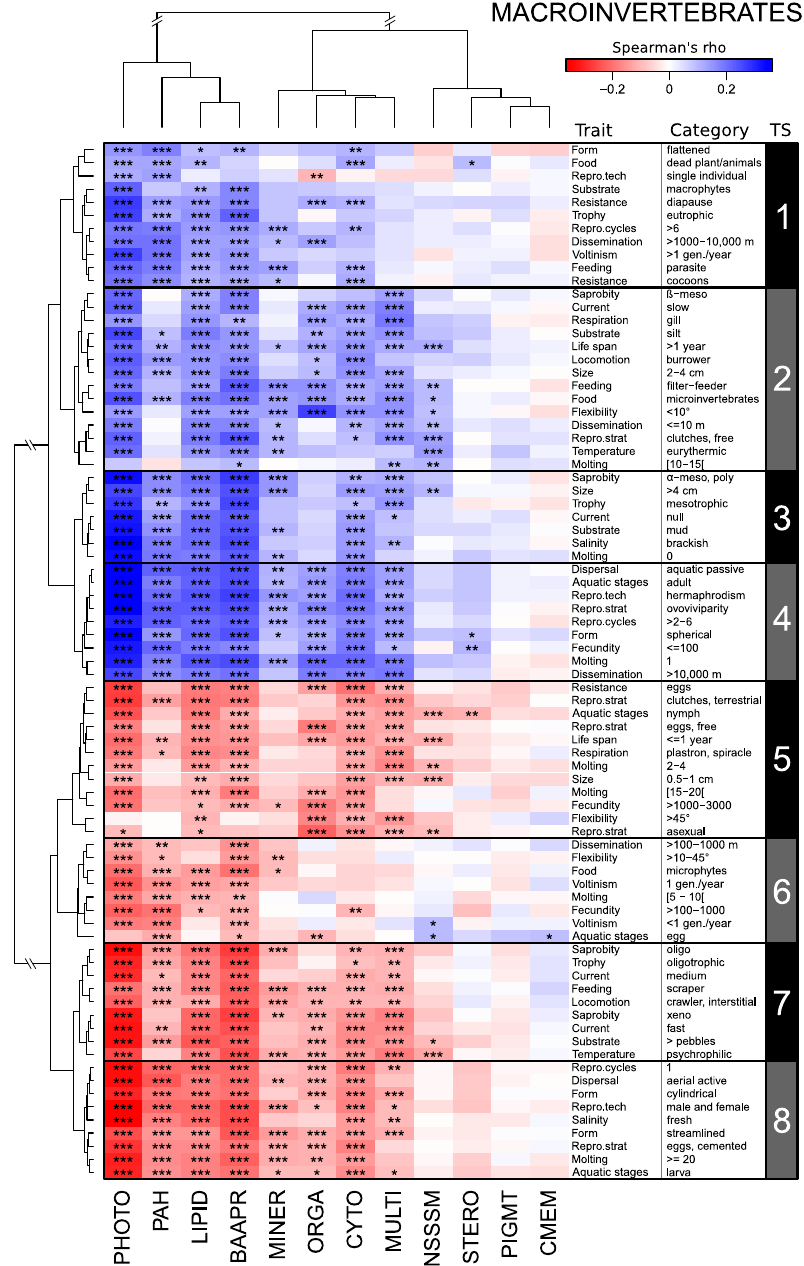
Figure 3. Heatmap of the non-parametric correlations between the utilization of trait categories by benthic macroinvertebrate assemblages (provided by CWM m calculation) and the 12 studied MoAs, expressed in terms of log(x + 1)-transformed sums of toxic units. The color of each cell indicates the value of the correlation coefficient (Spearman’s rho) for a given couple of “trait category × MoA”. Horizontal lines delimit trait syndromes, numbered (1 to 8) on the right side of the heatmap. The full labels of MoAs are in Table 1. Further details about the heatmap and the dendrograms are provided in the Section 2. * p < 0.05, ** p < 0.01 and *** p < 0.001. TS = trait syndrome. N = 2007 sampling